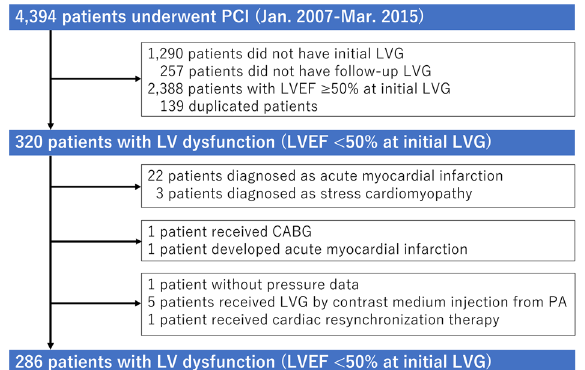
Figure 1. Flowchart of the study population. PCI percutaneous coronary intervention, LVG left ventriculography, LVEF left ventricular ejection fraction, CABG coronary artery bypass grafting, PA pulmonary